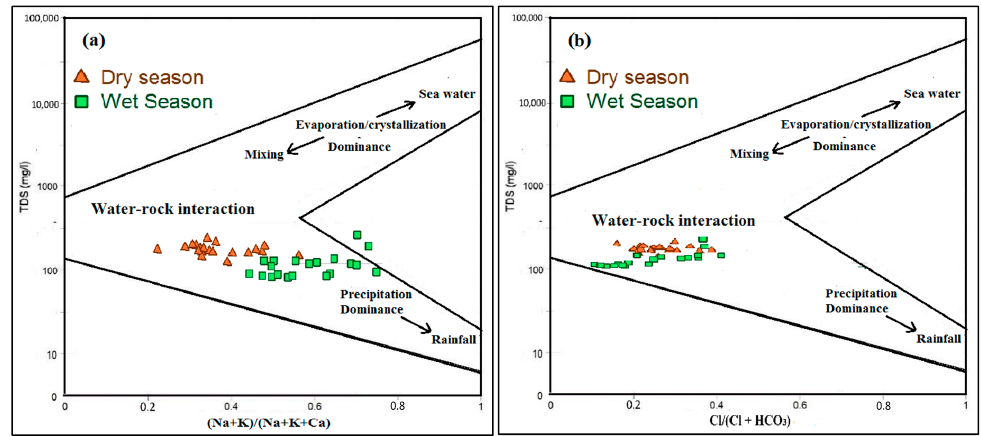
Figure 8. Gibbs graphs of the spring water sample: ( a ) cations; ( b ) anions (data from